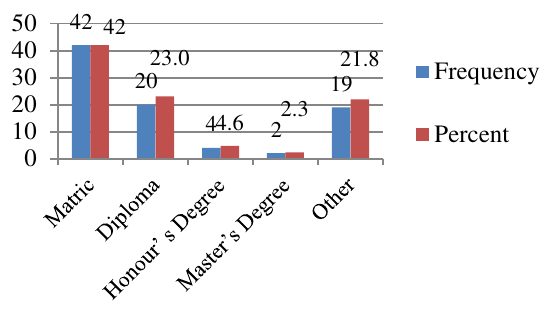
Fig. 4. Level of education of participants Figure 4 above determines that 42 participants (48.3